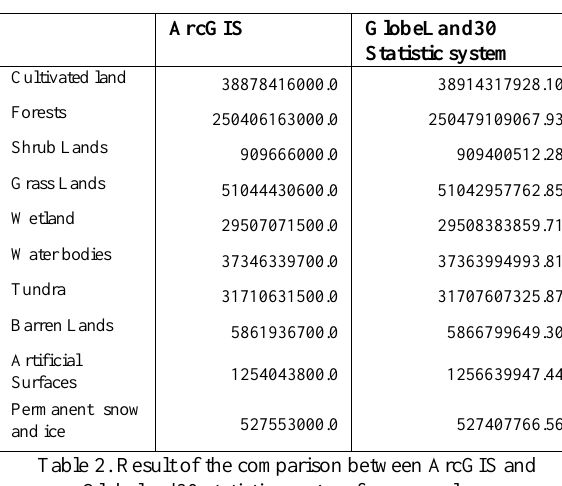
Table 2. Result of the comparison between ArcGIS and Globeland30 statistics system for every class.